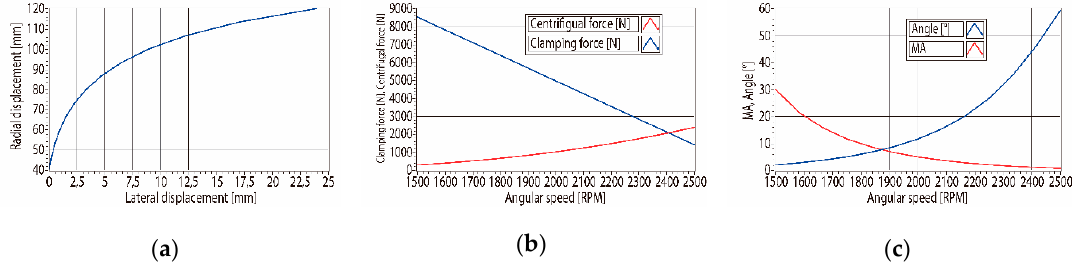
Figure 19. ( a ) The profile of the ramp on which the weight moves radially; ( b ) the available centrifugal force and the required clamping force as a function of the rpm; ( c ) mechanical advantage (MA) or relationship between the forces and the ramp angle to develop the clamping force.